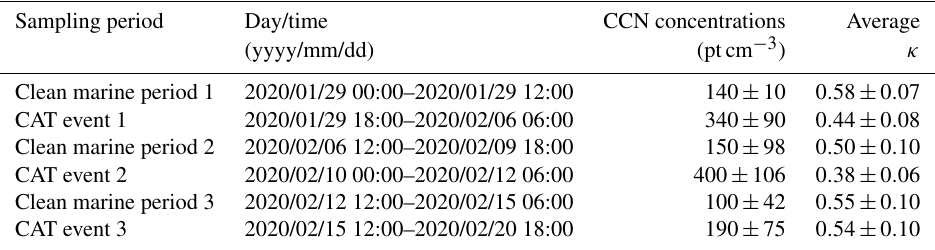
Table 1. Values for average CCN concentrations and κ measured at 0.16% S during each clean marine influence period and CAT event sampled during the EUREC 4 A and ATOMIC